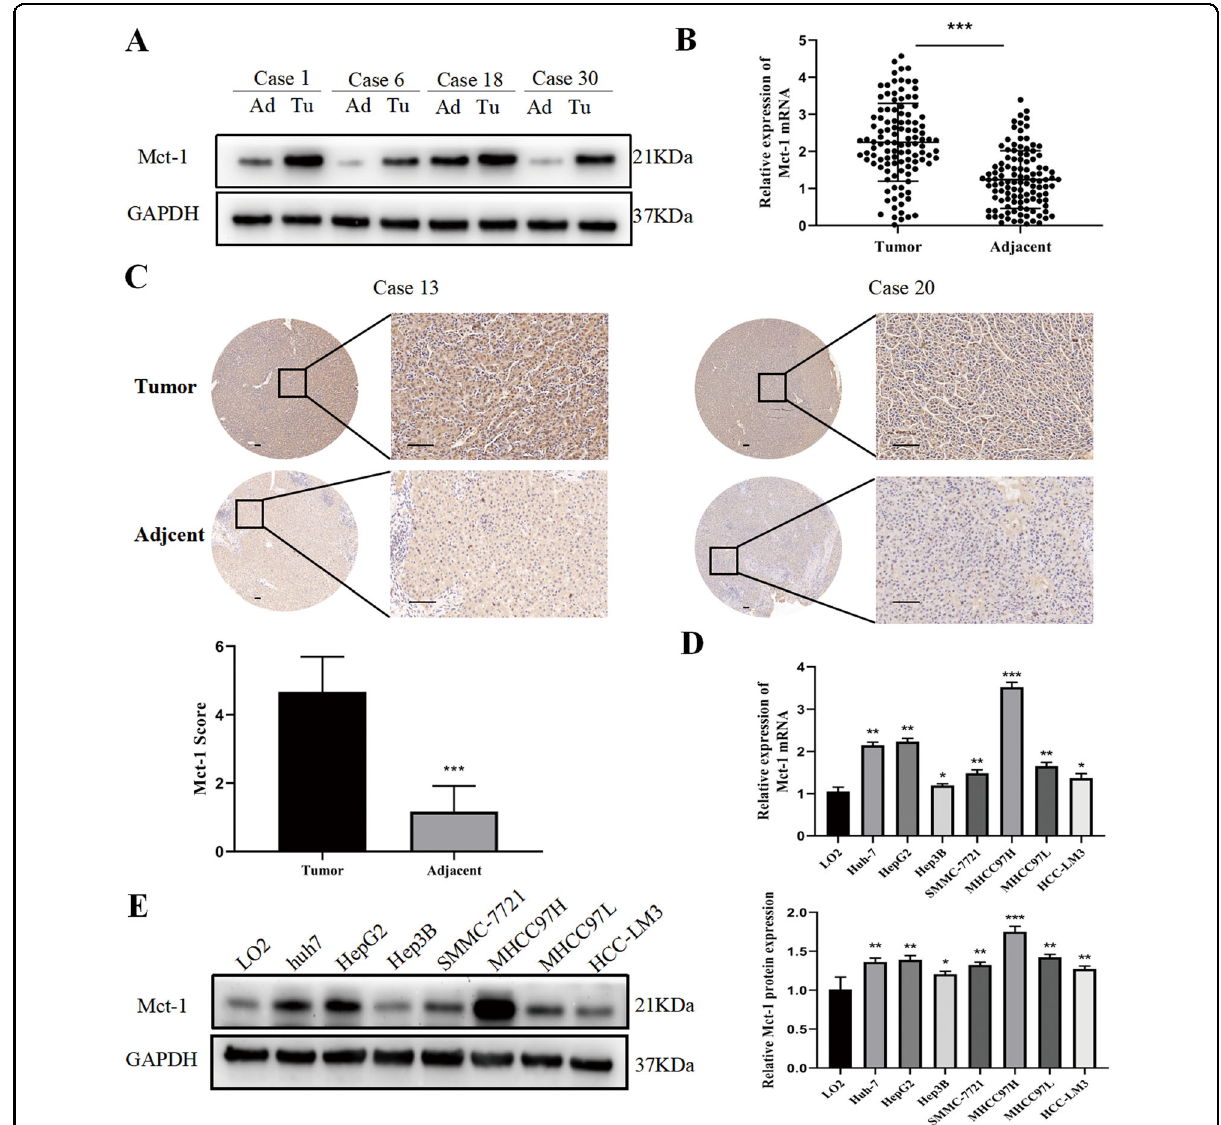
Fig. 1 Mct-1 expression is signi fi cantly upregulated in HCC tissues and cell lines. Mct-1 protein ( A ) and mRNA ( B ) levels in HCC tumor tissues and corresponding adjacent nontumor tissues. C Representative IHC staining of Mct-1 in HCC tumor tissues as compared with peritumor tissues. Scale bar = 50 µm. D Mct-1 mRNA and E protein expression levels in HCC cell lines and normal LO2 cells by qRT-PCR and western blot analyses. * p < 0.05, ** p < 0.01, *** p <